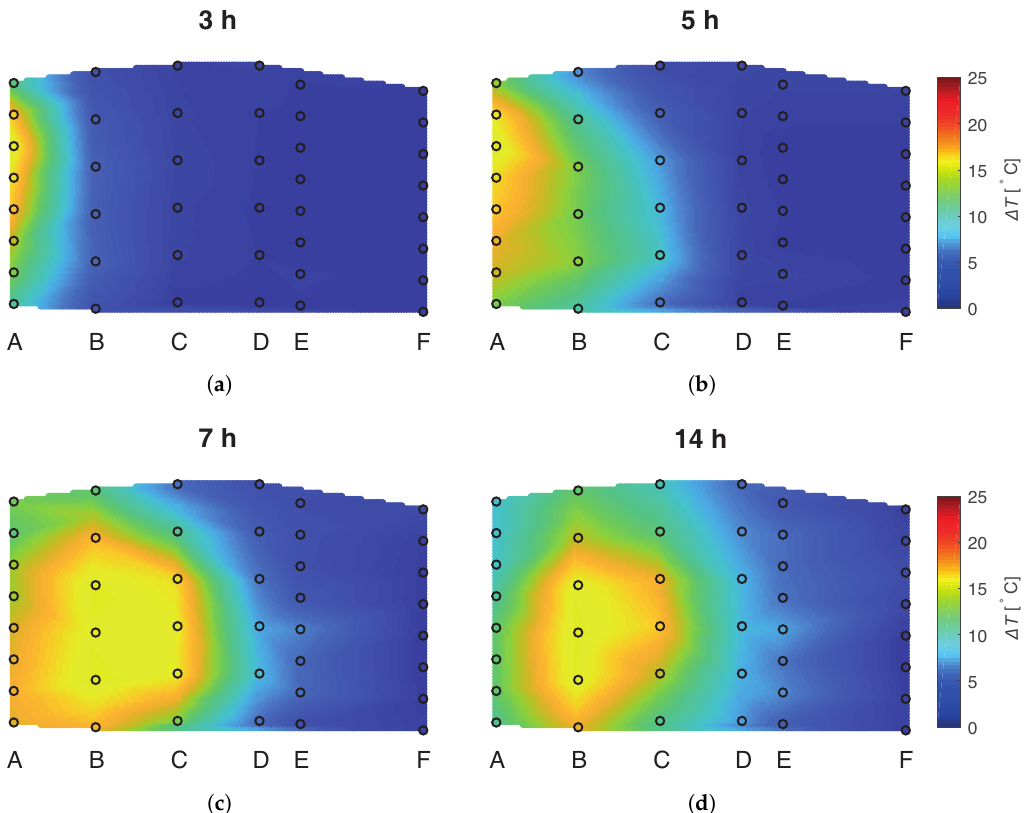
Figure 7. The time evolution of the thermal plume in the AS at four different moments: ( a ) t = 3 h; ( b ) t = 5 h; ( c ) t = 7 h; ( d ) t = 14 h from the start of the experiment. The black circles indicate the calculated temperature from the FBG sensors. The displayed temperature map was generated by a linear interpolation from the FBG